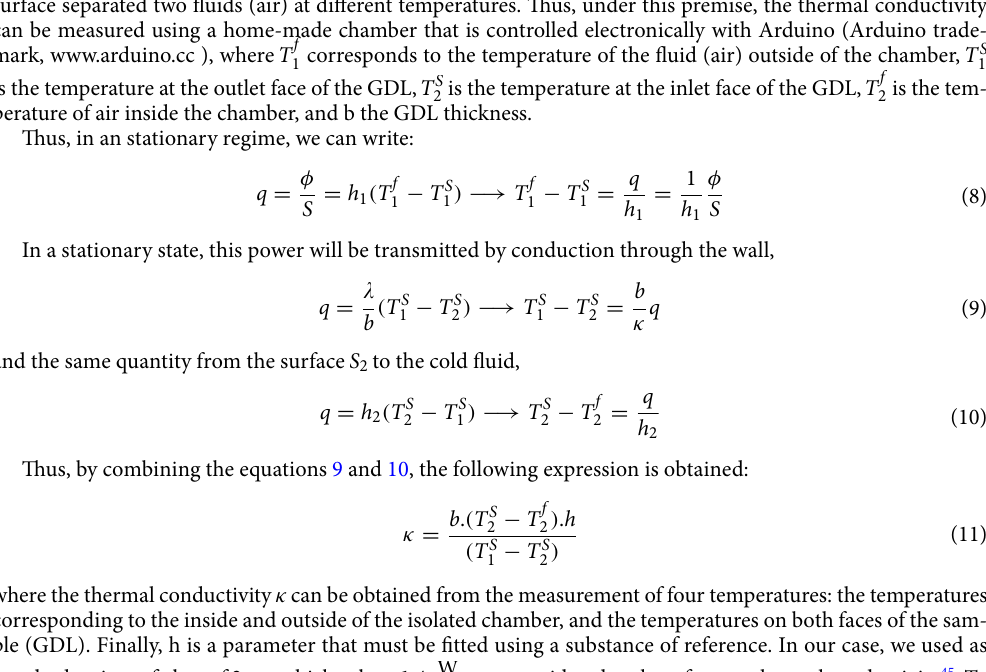
Thermal conductivity, κ .